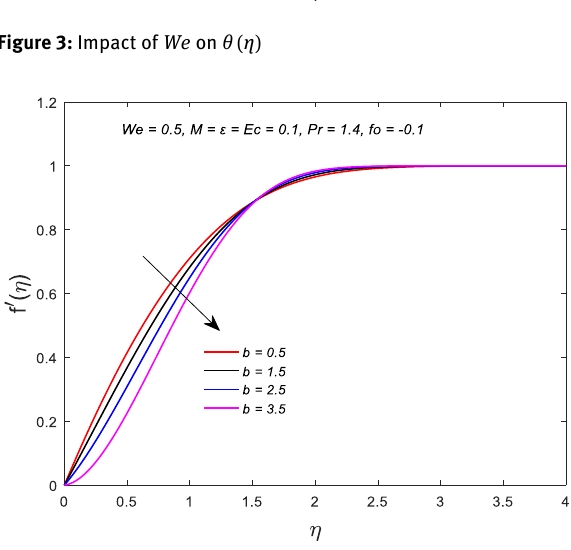
Figure 3: Impact of We on θ ( η )